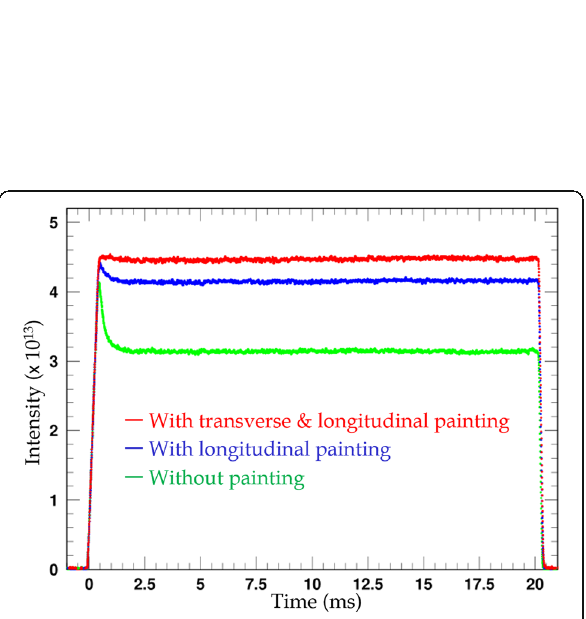
Fig. 18 Experimental results at the J-PARC RCS; circulating beam intensities from injection to extraction measured without and with phase-space painting